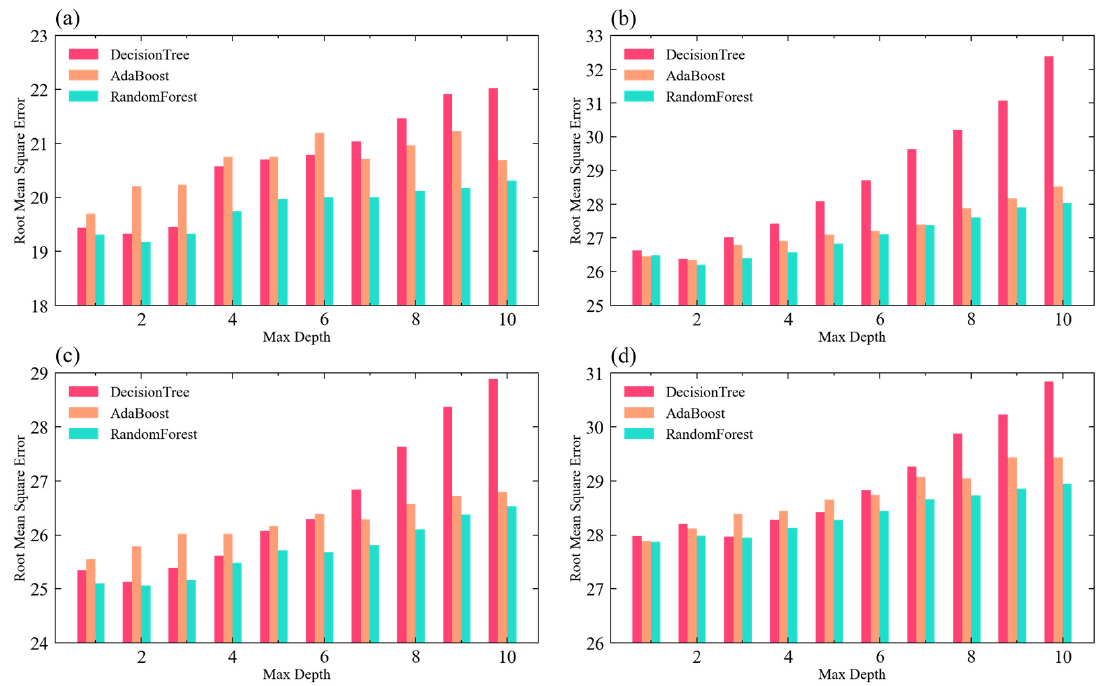
Figure 6. Variation of root mean square error with the maximum depth ( a ) South China, ( b )East China, ( c ) North China, and ( d ) East North.